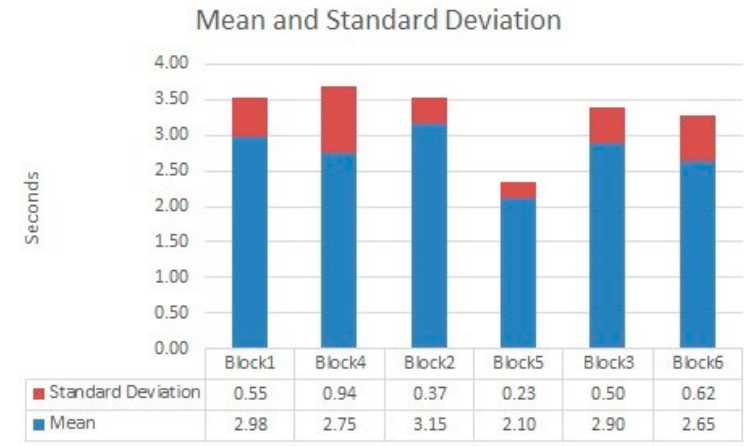
Figure 15. Mean and standard deviation for values of uWT .